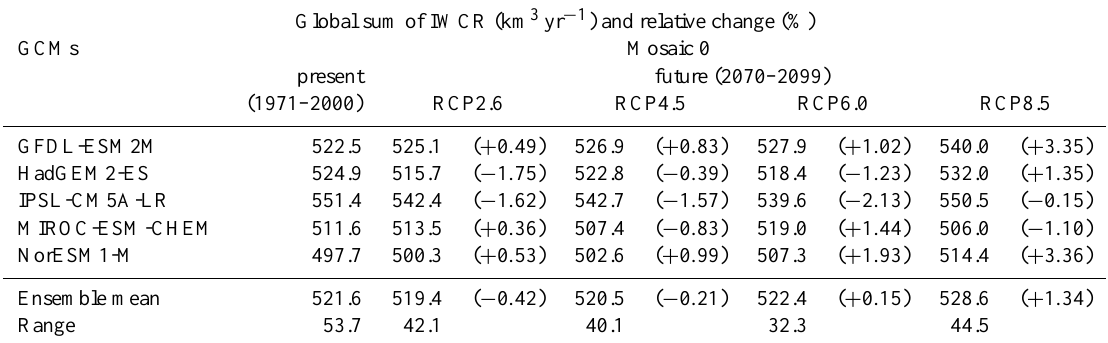
Figure 6. Same as Fig. 4 but for the precipitation. Table 4b. Results of the present (1971–2000) estimation and future (2070–2099) projection of irrigation water consumption from rivers (IWCR). The values in parentheses are changes (%) relative to the present values. The range (the difference between the maximum and minimum) of the five GCMs is given in the bottom